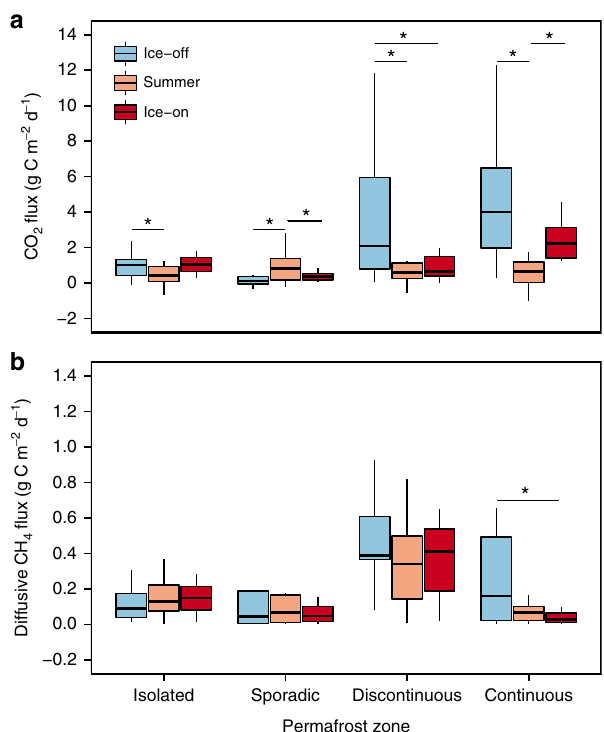
Fig. 2 Seasonal CO 2 fl ux and diffusive CH 4 fl ux across different permafrost zones. The panel ( a ) refers to CO 2 fl ux whereas panel ( b ) refers to diffusive CH 4 fl ux. Boxes are bound by 25th and 75th percentiles, whiskers show 1.5 interquartile range. Solid line represents median values while the star signi fi es statistically signi fi cant differences. Positive values indicate outward fl ux from the lakes into the atmosphere. We removed 12 outliers on panel ( a ) and 14 outliers on panel ( b ) to visually improve the graph, but used the complete dataset for statistical analyses. For sample size